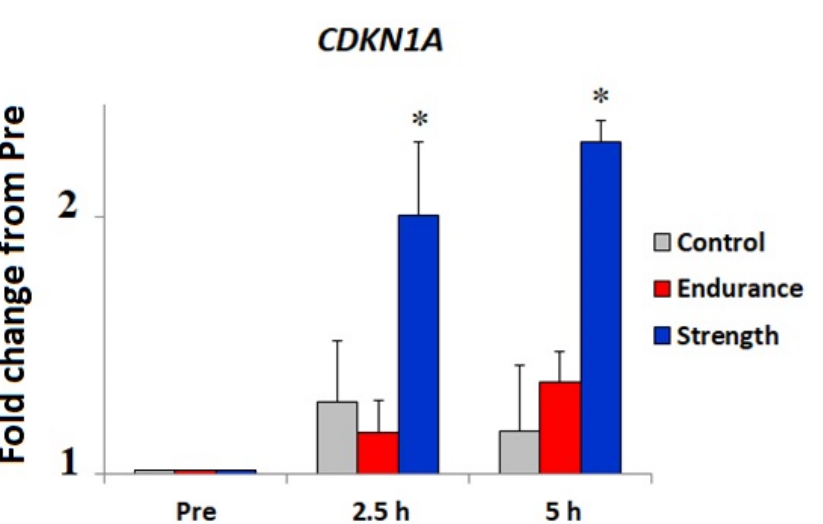
Figure 2. Effect of acute endurance ( n = 7) and strength ( n = 7) exercise on CDKN1A gene expression of m. vastus lateralis of young men. Time points corresponding to Pre, 2.5, and 5 h post -exercise are shown. * p < 0.0001. This figure was generated using publicly available data from Vissing and Schjerling [48].